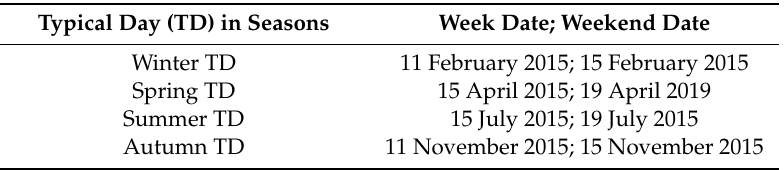
Table 6. Selected typical days ( date format: yyyy-mm-dd